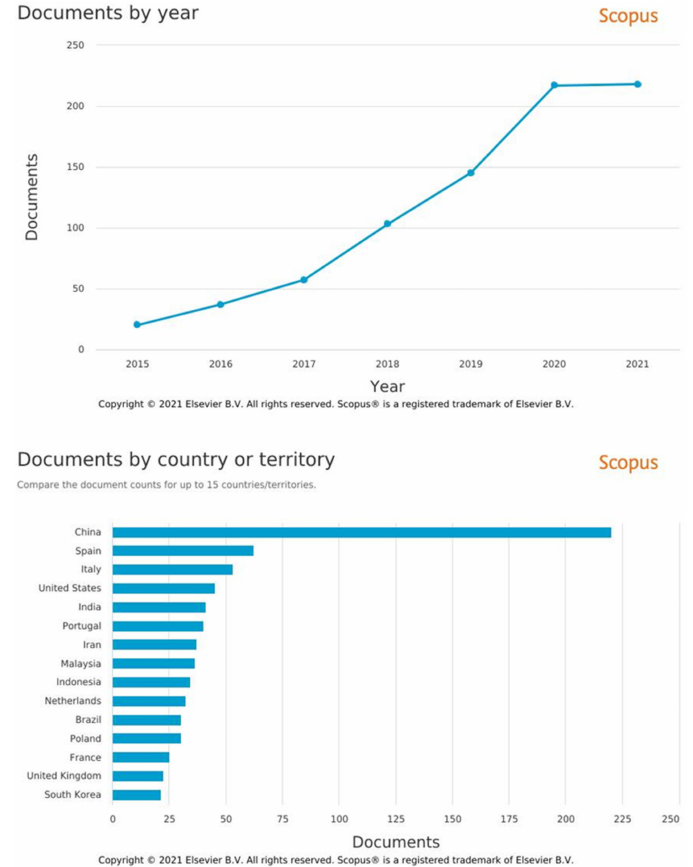
Figure 1. Bibliographic metrics from Scopus (https://www.scopus.com/, accessed on 28 September 2021), with “Natural Deep Eutectic Solvents” keywords, from 2015 to